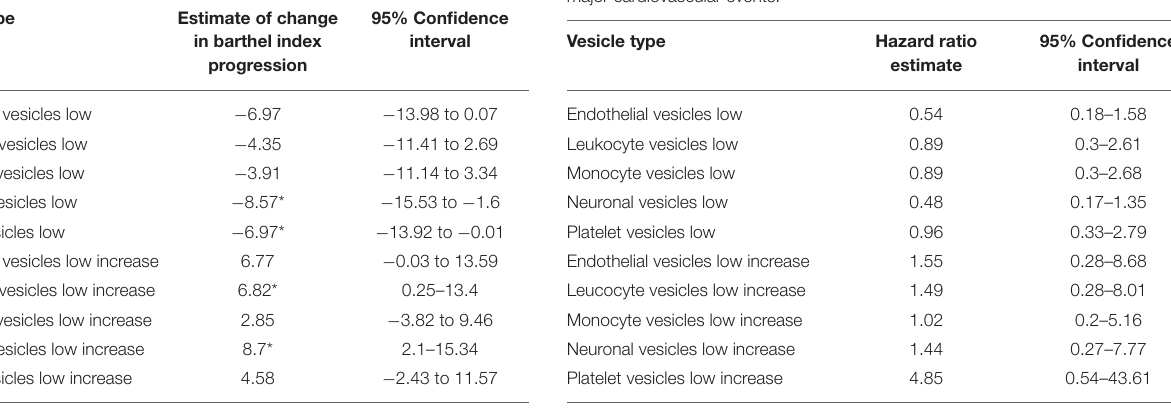
TABLE 5 | Adjusted proportional hazard ratio of cox regression and 95% confidence interval for vesicles at baseline and their dynamic for the occurrence of major cardiovascular